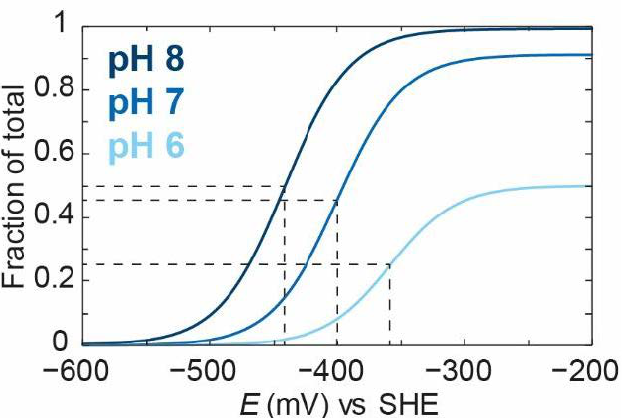
Figure 6. Variation of the fraction (out of 1) of deprotonated oxidised ( Ox ) species as a function of the applied potential at pH 6 (light blue), pH 7 (medium blue), and pH 8 (dark blue). The curves were obtained using Equations (7), (11), (12), and (15), with E O = − 459 mV, K a, 1 = 10 − 6 ( pK a, 1 = 6), 1 K a, 2 = 10 − 8 ( pK a, 2 = 8). E O was calculated using Equation (21) to be − 341 mV, giving an average E O 2 of − 400 mV, for a comparison with Figure 2.